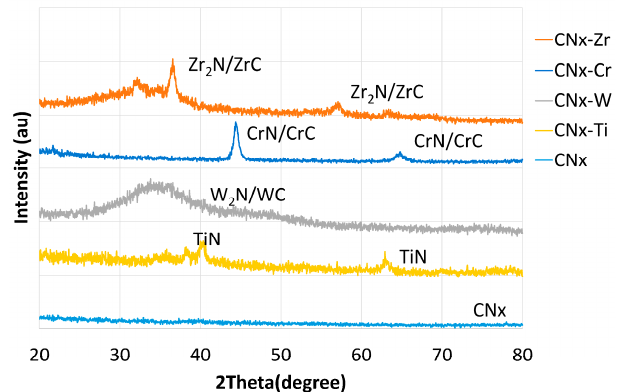
Figure 5. XRD patterns of CNx and 6 at. % metal-doped CNx coatings.